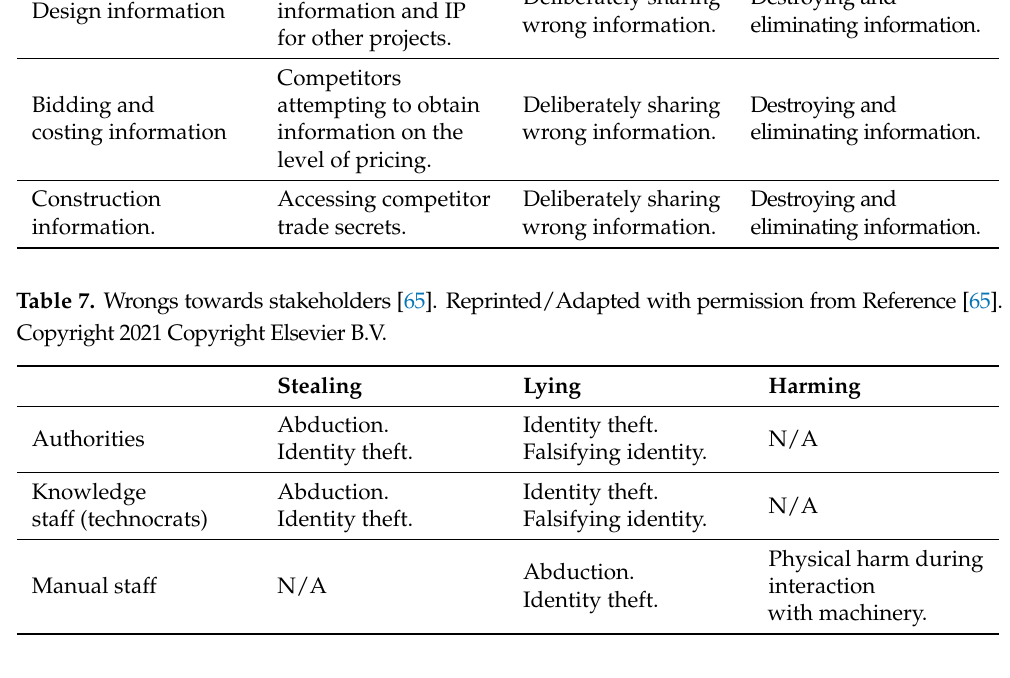
Table 8. Wrongs that can happen to materials and resources [65]. Reprinted/Adapted with permission from Reference [65]. Copyright 2021 Copyright Elsevier